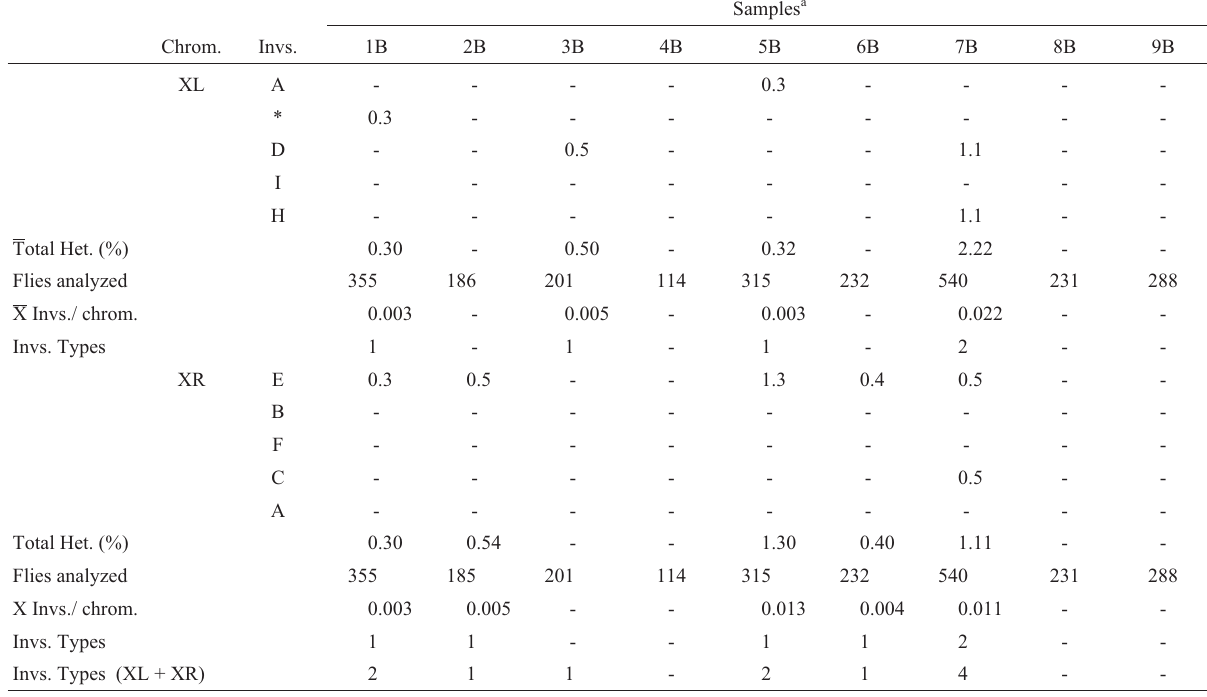
Table 3 - Frequency (%) of inversions, total heterozygosis, and mean number of inversions per each arm of the X chromosome of Drosophila willistoni populations from Rio Grande do